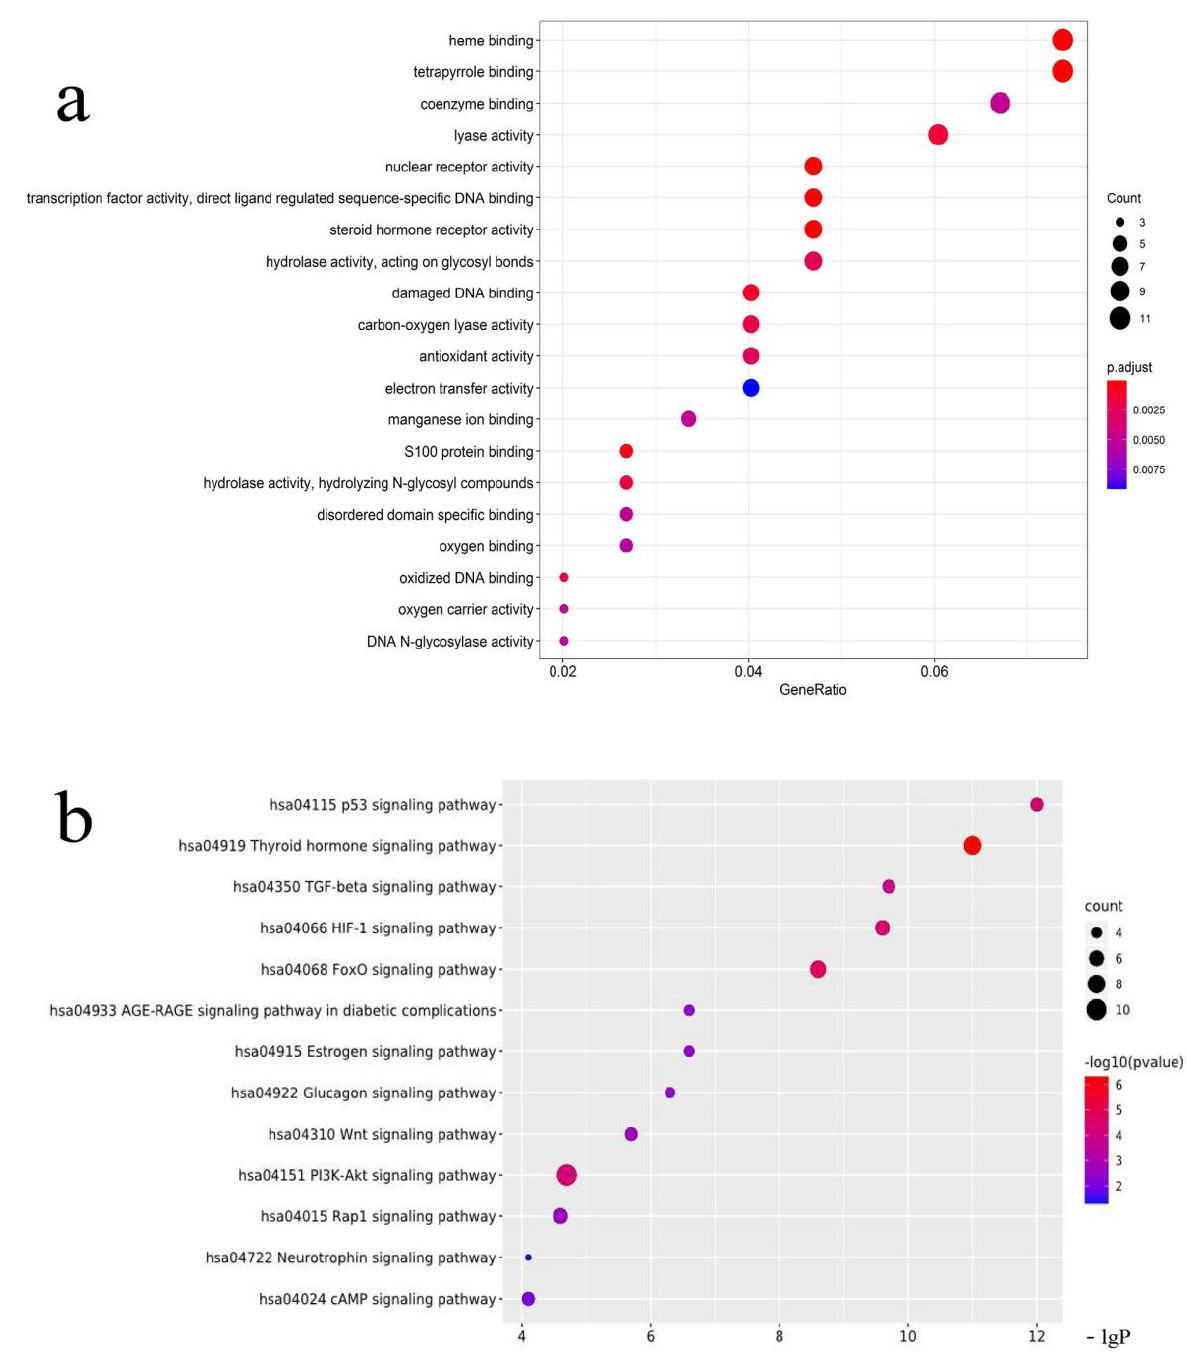
Figure 7. ( a ) GO analysis diagram. ( b ) KEGG enrichment map.